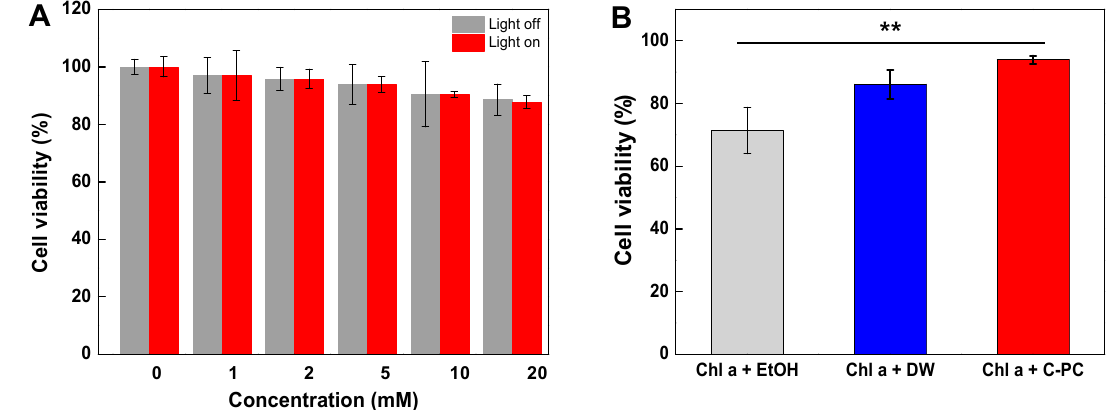
Figure 5. Viability of HepG2 cells treated with ( A ) various concentrations of only C-PC and ( B ) Chlorophyll a (Chl a, 20 mM) in EtOH, DW, and C-PC for 12 h with illumination (** p < 0.01).